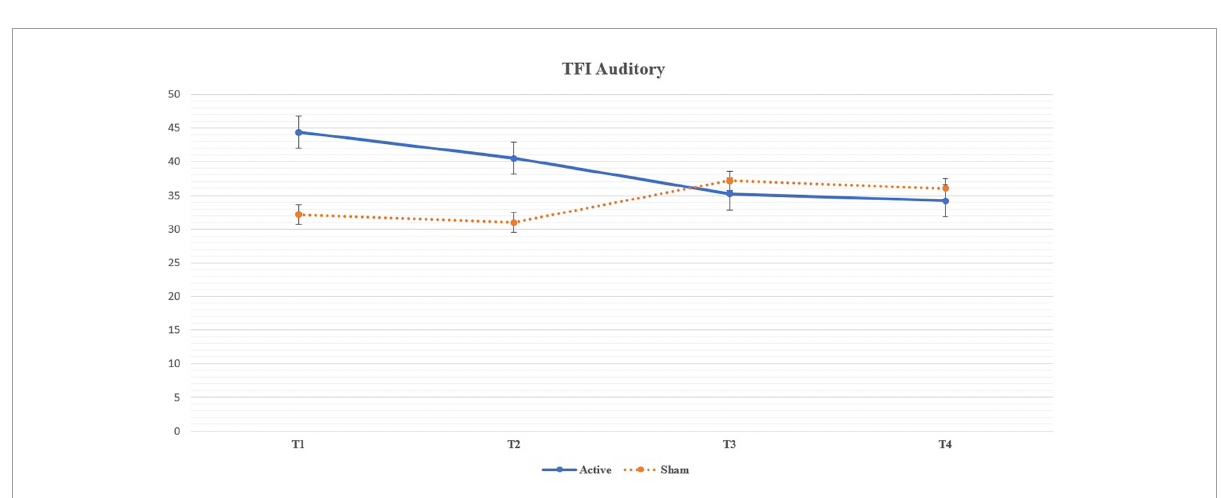
FIGURE4 Line chart depicting the mean values of the Auditory subdomain of Tinnitus Functional Index throughout the trial and their side-by-side comparison between the arms. The results in T3 and T4 are statistically significant a denote a decrease (improvement) in the Auditory subdomain of the active